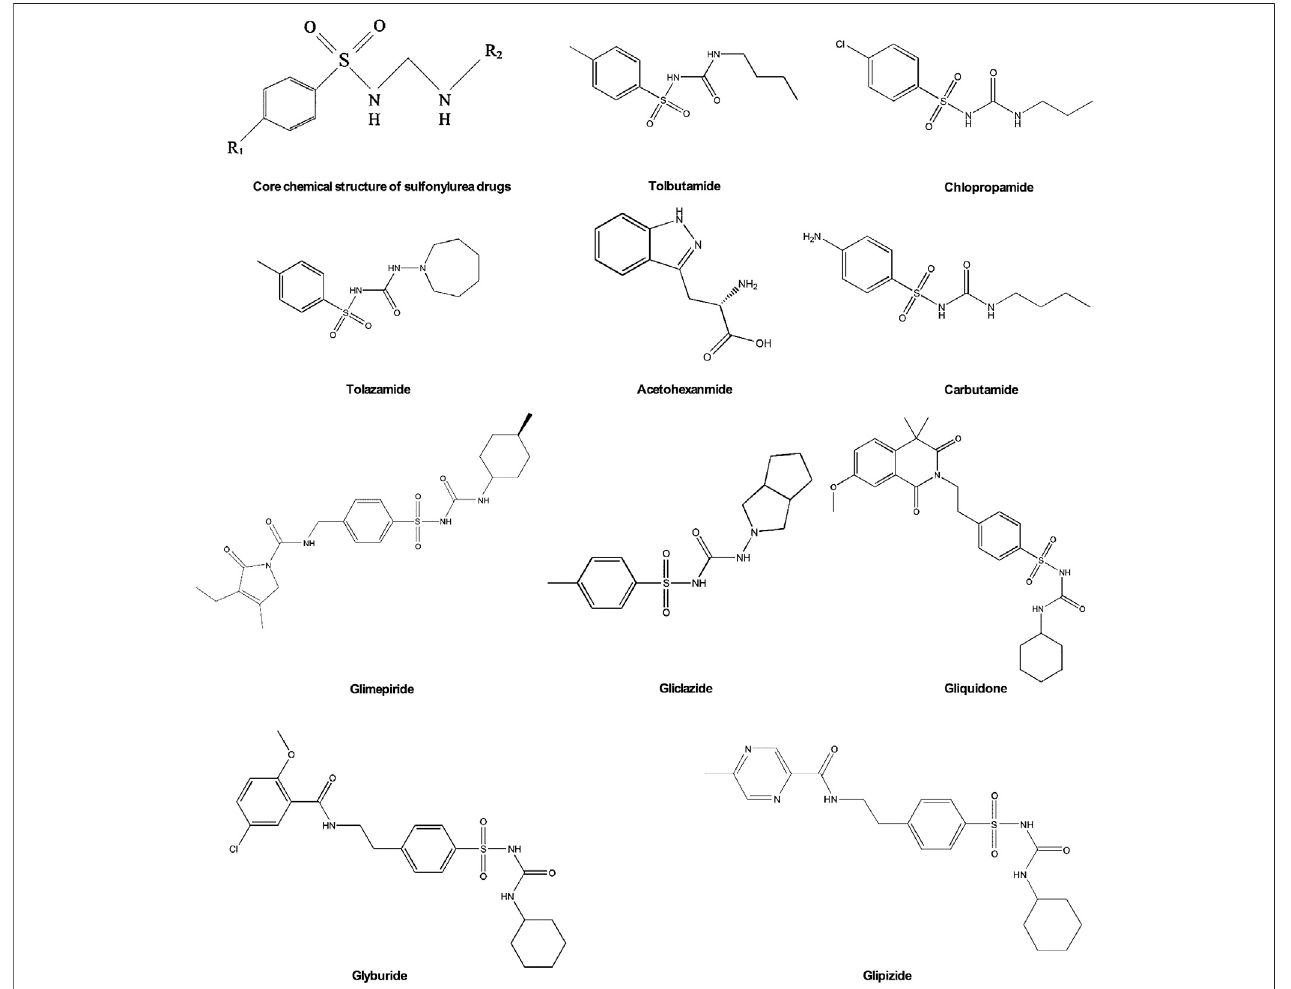
FIGURE 3 | Chemical structures of